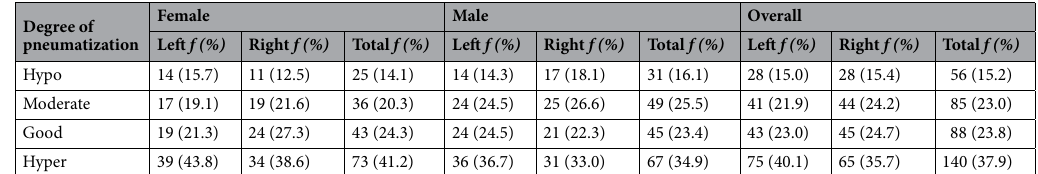
Table 1. Overall degree of temporal bone pneumatization, including sex and laterality. f frequency; % percentage.